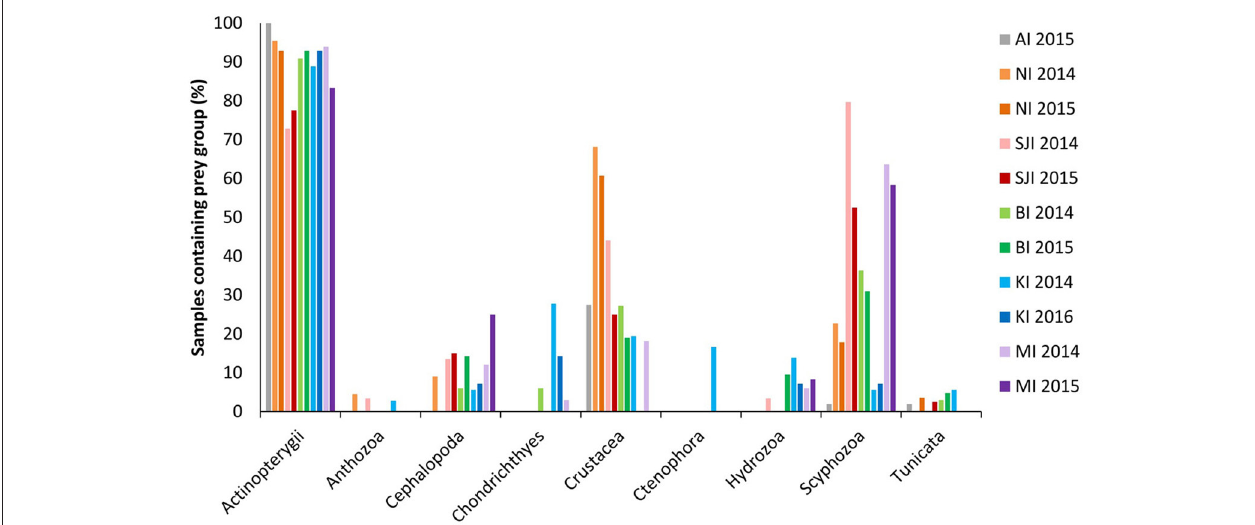
FIGURE 2 | Overall prey groups found in black-browed albatross scats from 2014 to 2016 using 18S_SSU primers. Sites were New Island (NI) and Steeple Jason Island (SJI), Falkland Islands; Bird Island, South Georgia (BI); Canyon des Sourcils Noirs, Iles Kerguelen (KI); and Macquarie Island (MI). Values represent the frequency of occurrence for each site. Lighter colored bars correspond to 2014, darker bars to 2015 (or 2016 for Iles Kerguelen). A prey group was considered to be present if it contributed > 1% of the total sequences for that sample. Further details on the non-fish prey groups can be found in McInnes et al. (2017b).